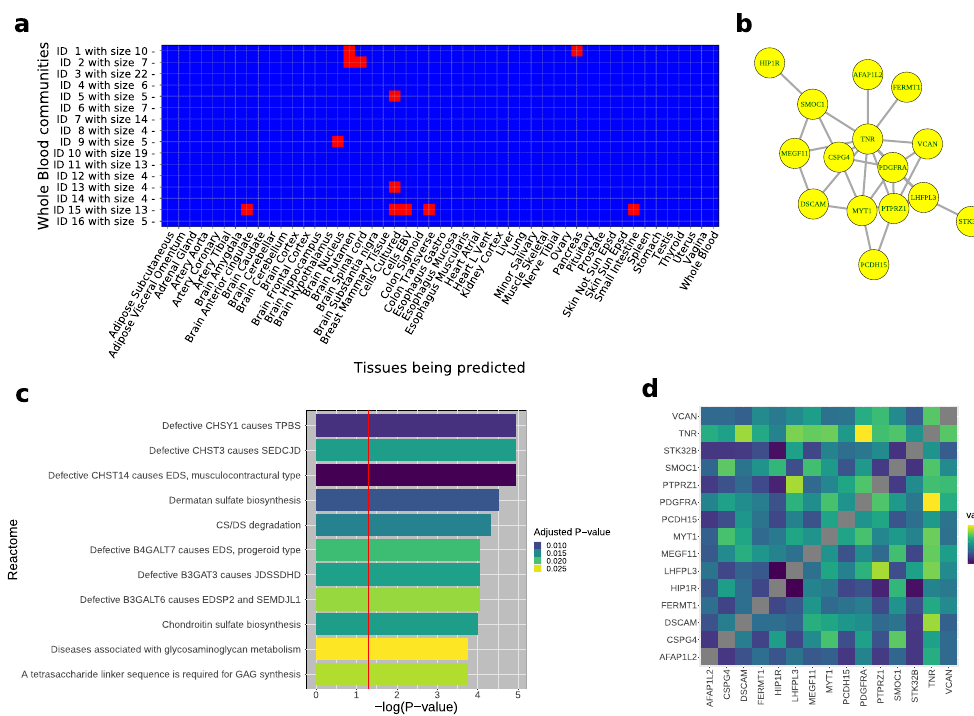
Fig. 5 Communities and their properties. We developed tools (available on github) to query a community for its characterization. a Prediction power of "Whole Blood'' communities, in F 1 scores thresholded over 0.8. Most communities in "Whole Blood'' do not have prediction power for the remaining tissues. Notable exceptions include a 13-member community, which can predict multiple tissues, including "Brain Anterior cingulate'', "Small Intestine'', and "Colon Transverse''. b A 15-member community in the hippocampus is shown here as an example. An edge indicates A ij > 0.80 for genes i and j . The gene TNR , which is expressed primarily in the central nervous system and involved in its development, is connected via an edge to twelve member genes while HIP1R is connected to only one. c Enrichment analysis was performed on all communities to identify known biological processes. For example, the hippocampal community in b was found to be signi fi cantly enriched for Reactome pathways. p -value refers to raw p -value. Red line corresponds to the raw p < 0.05 threshold. Color gradient re fl ects the adjusted p -value. All Reactome pathways shown meet adjusted p < 0.05. d Heatmap displays the correlation values for the member genes of the community in b